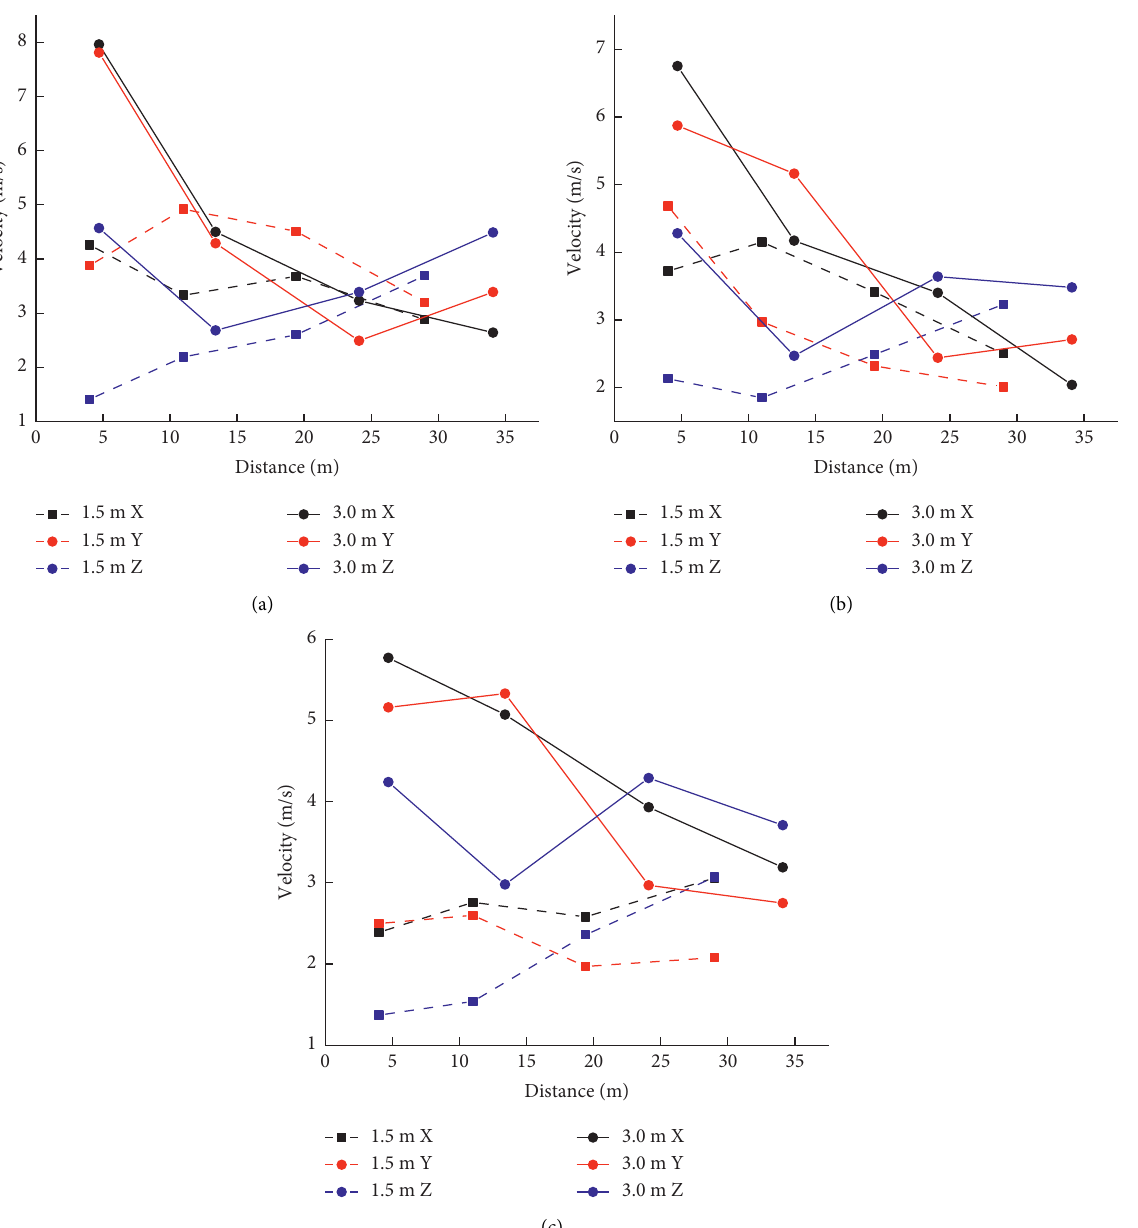
Figure 3: Comparison of 3D vibration velocities of typical blasting segments with different footage conditions ahead of the corresponding blasting face. (a) Cutting segment, (b) floor segment, and (c) contour